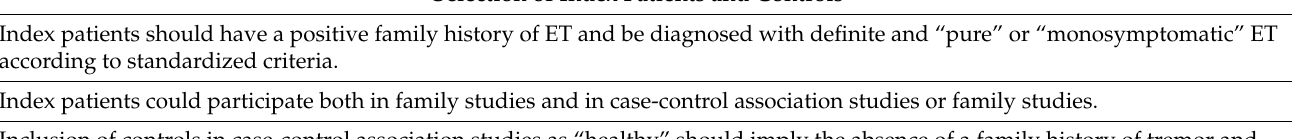
Table 4. Design recommendations for studies focused on genetic research of essential tremor (adapted from text of Reference